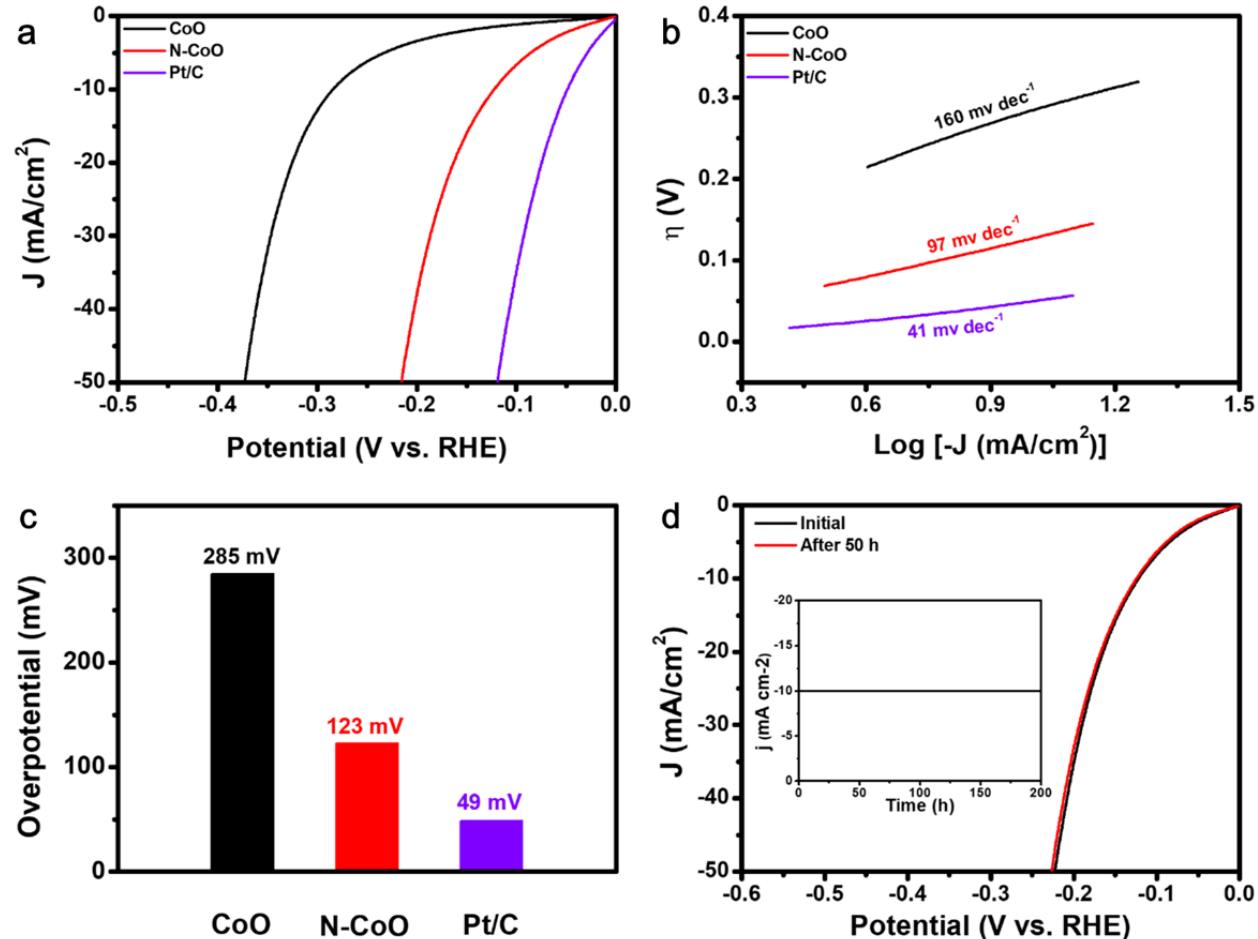
Figure 4. ( a ) LSV curves of the CoO and N-CoO nanowires, with a state-of-the-art Pt/C catalyst as the control sample. ( b ) Tafel slopes of the CoO and N-CoO nanowires, with a state-of-the-art Pt/C catalyst as the control sample. ( c ) The overpo- tential of the CoO and N-CoO nanowires at a current density of 10 mA cm − 2 , with a state-of-the-art Pt/C catalyst as the control sample. ( d ) The initial and post-50 h stability tests at 10 mA cm − 2 LSV curves of the N-CoO nanowires. The inset is the chronoamperometric curve recorded at − 0.123 V (10 mA cm − 2 ).